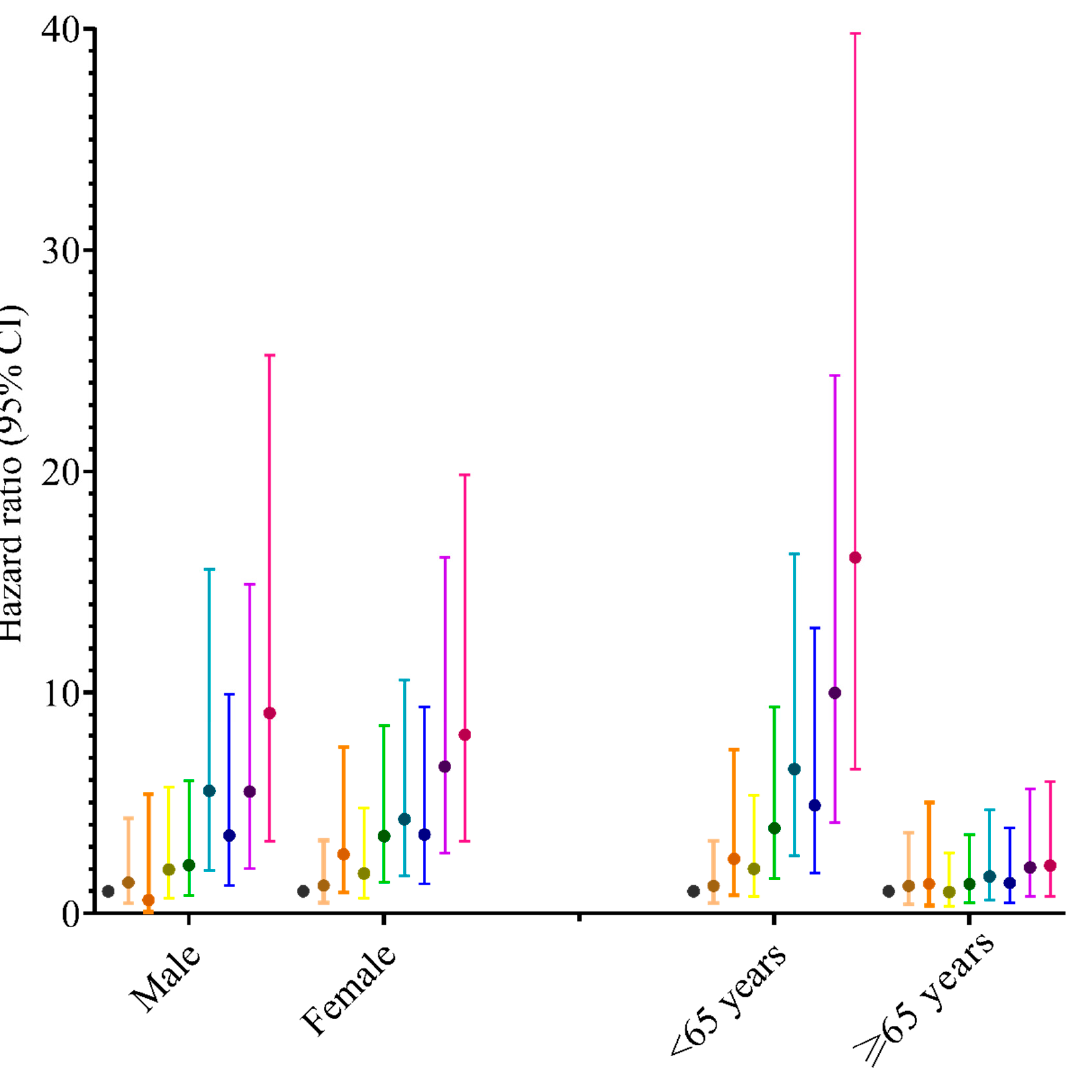
Figure 3. The joint associations of healthy behaviours and socioeconomic status on respiratory disease mortality by gender and age. Models all adjusted for age, gender, race and ethnicity, general health, weight loss, diabetes, cardiovascular disease, cancer, family history, poor psychological status, sleep duration, coffee intake, and consumption of tea. Nine joint groups are presented in the following order: High SES and four or five healthy behaviours, high SES and two or three healthy behaviours, high SES and no or one healthy behaviour, medium SES and four or five healthy behaviours, medium SES and two or three healthy behaviours, medium SES and no or one healthy behaviour, low SES and four or five healthy behaviours, low SES and two or three healthy behaviours, low SES and no or one healthy behaviour. 95% CI = 95% confidence interval. SES = socioeconomic status.